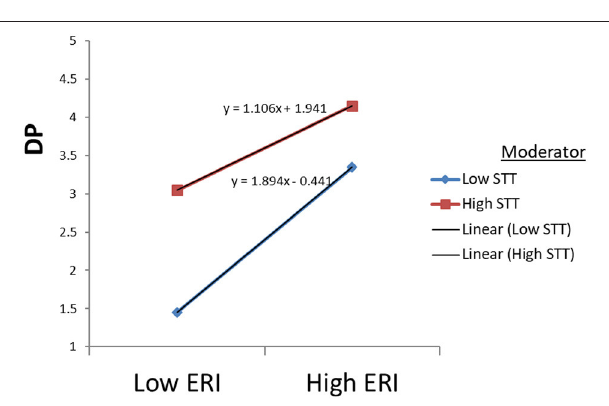
FIGURE 2 | Moderating effects of STT on DP through